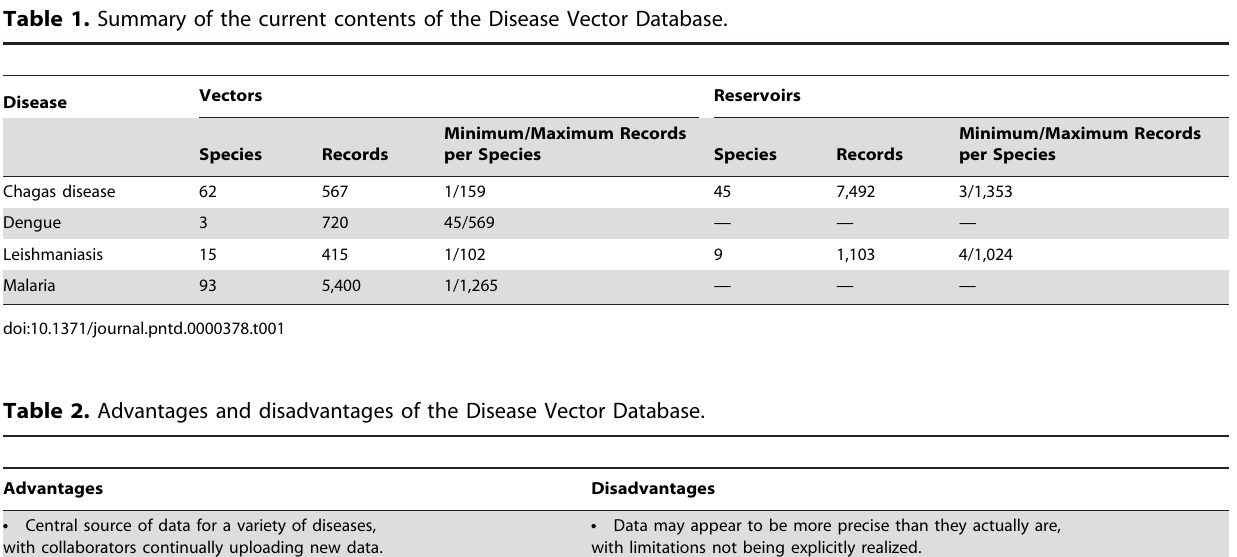
Table 1. Summary of the current contents of the Disease Vector Database.